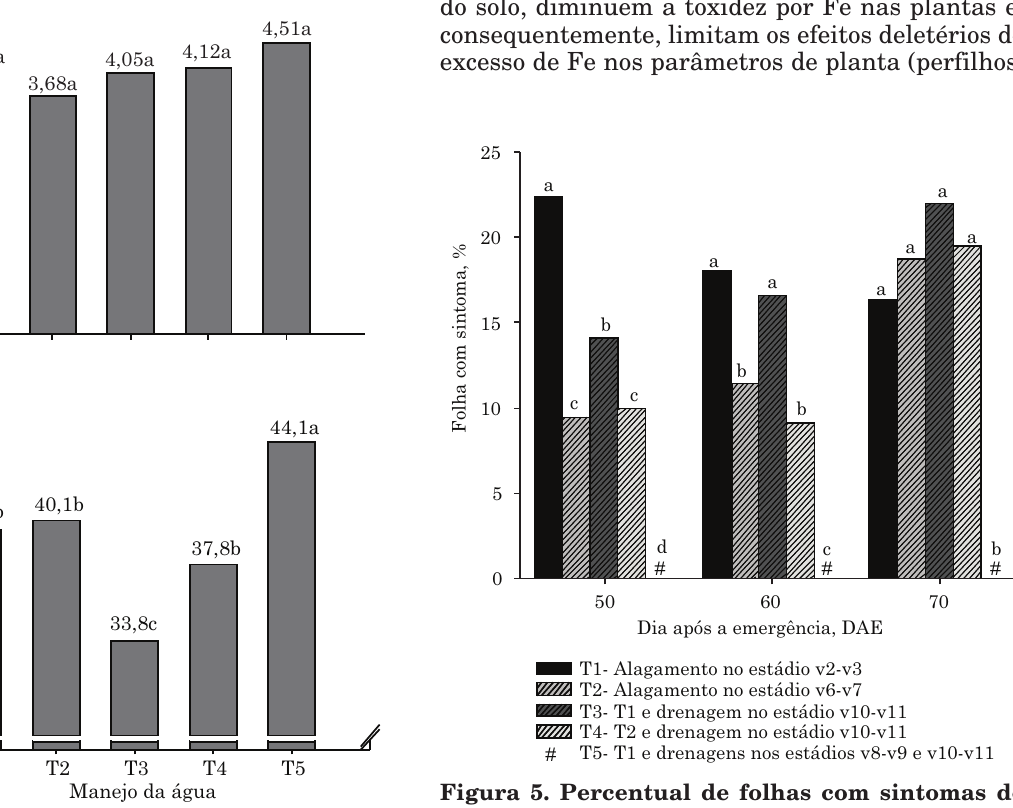
Figura 4. Produção de matéria seca da parte aérea de duas plantas de arroz coletadas aos 42 dias (a) e das duas plantas restantes, aos 70 (b) dias, após a emergência